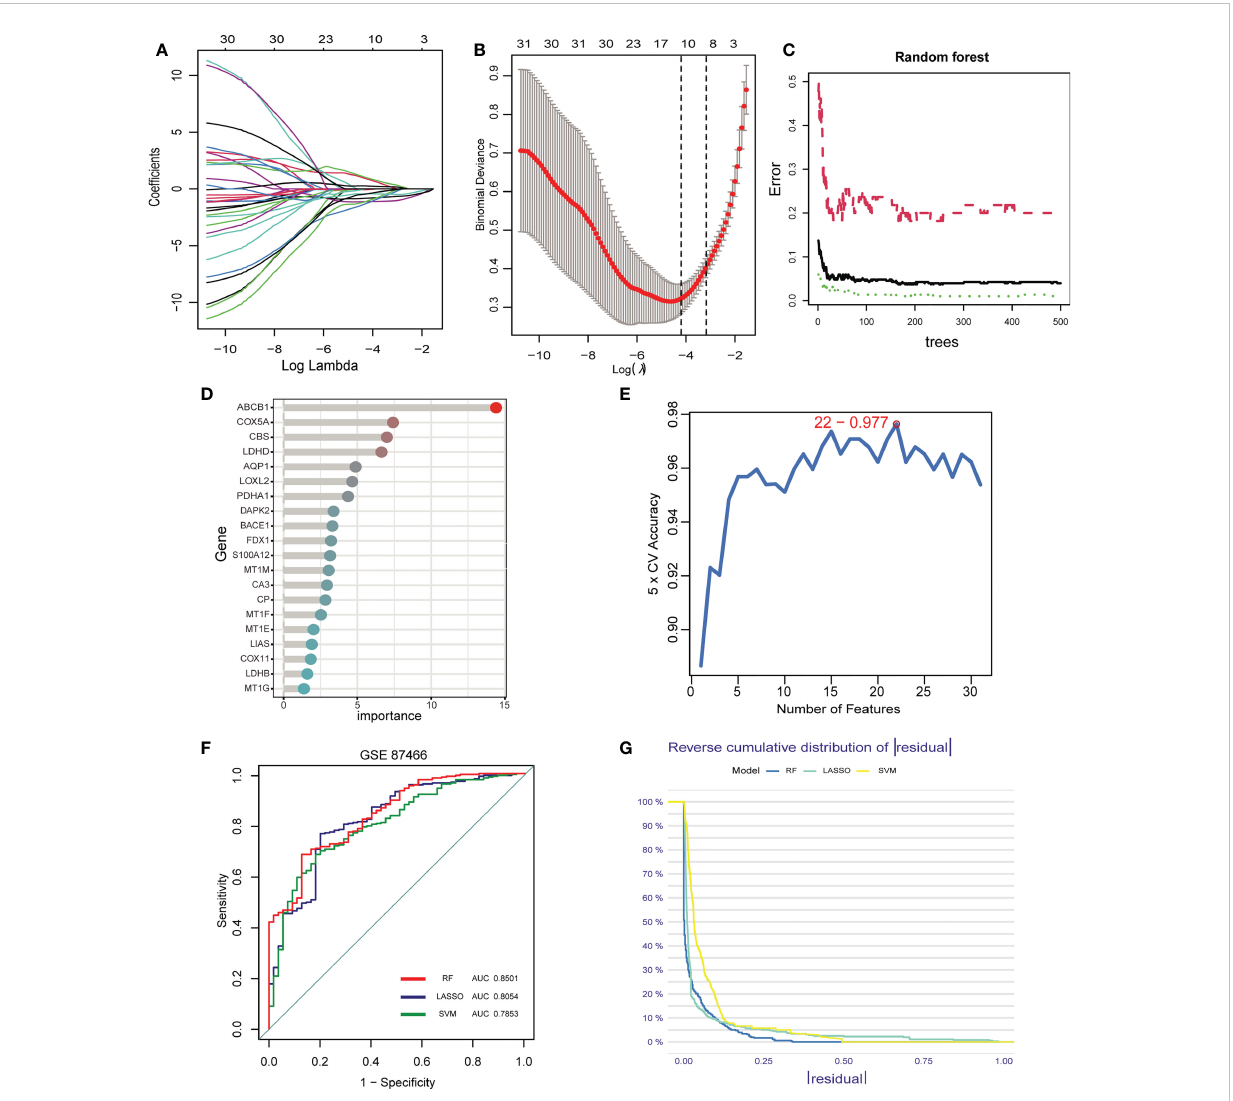
FIGURE 4 Screening of signature genes by machine learning. (A-E) . Construction of signature genes using LASSO regression (A, B) , SVM-RFE (C, D) , and RF algorithm (E) . (F) The ROC curves and AUC values demonstrate the screening performance of the three machine learning algorithms. (G) Cumulative residual distributions for the three machine learning algorithms (RF, LASSO, and